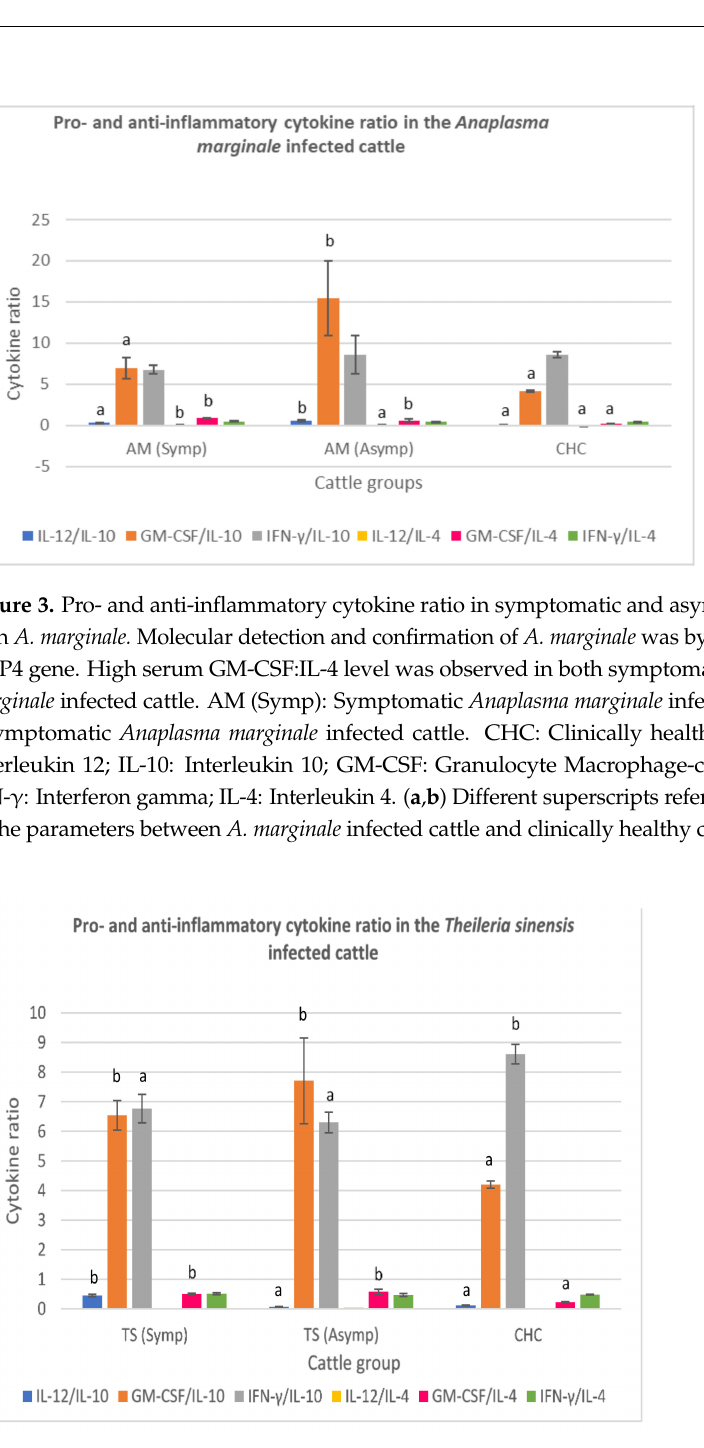
Figure 4. Pro- and anti-inflammatory cytokine ratio in symptomatic and asymptomatic cattle infected with Theileria sinensis. Molecular detection and confirmation of blood pathogens were by PCR ampli-fication of MPSP gene. High serum GM-CSF: IL-10 and GM-CSF:IL-4 ratios were observed in both symptomatic and asymptomatic Theileria sinensis infected cattle, respectively. TS (Symp): Symp-tomatic Theileria sinensis infected cattle. TS (Asymp): Asymptomatic Theileria sinensis infected cattle. CHC: Clinically healthy cattle. (control). IL-12: Interleukin 12; IL-10: Interleukin 10; GM-CSF: Granulocyte Macrophage-colony stimulating factor; IFN- γ : Interferon gamma; IL-4: Interleukin 4. ( a , b ) Different superscripts refer to significant differences in the parameters between T. sinensis infected cattle and clinically healthy cattle ( p <